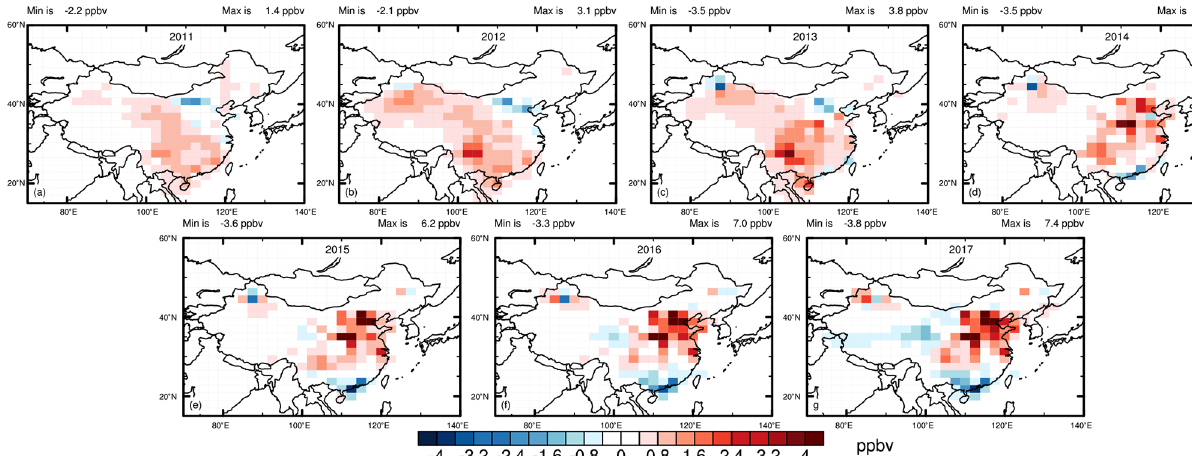
Figure 3. Same as Fig. 2 but for annual MDA8 O 3 changes.